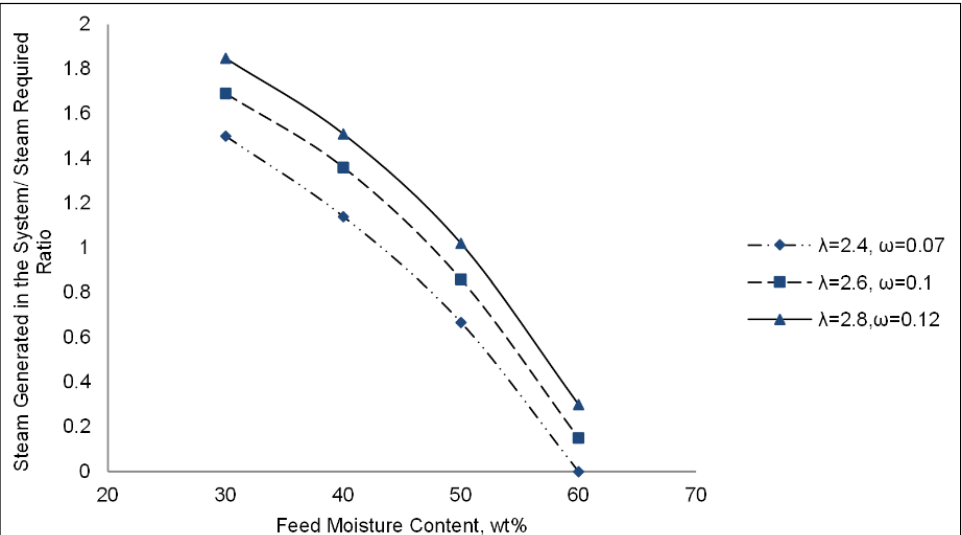
Figure 12. The effect of feed moisture content on the steam generated in the system, T = 850 °C and S / B =